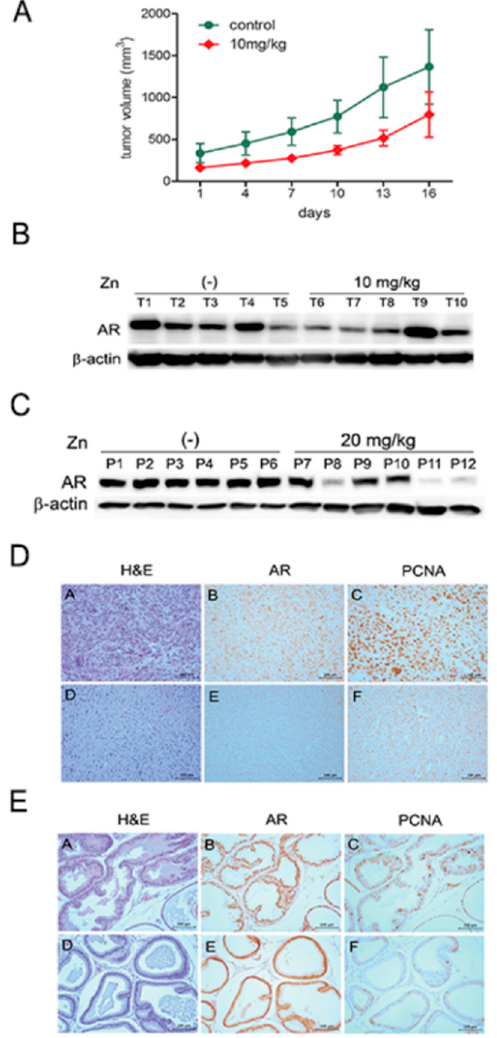
Figure 6. Zinc suppresses PCa cell growth in vivo. ( A ) Mouse TRAMP-C2 cells were subcutaneously inoculated into syngeneic mice and xenograft tumor growth was monitored after intraperitoneal injection of 10 mg/kg ZnCl 2 twice a week. ( B ) After animals were sacrificed, tumors were collected and lysed, and AR expression was detected by Western blotting. ( C ) Seven-week-old male mice were treated with 10 or 20 mg/kg ZnCl 2 twice by peritoneal injection. Nine days later, whole prostates were isolated and subjected to Western blot analysis. ( D , E ) Immunohistochemical analyses of tumors from ( A , D ) and normal prostates from ( C , E ) were performed. Bars indicate 100 µm.